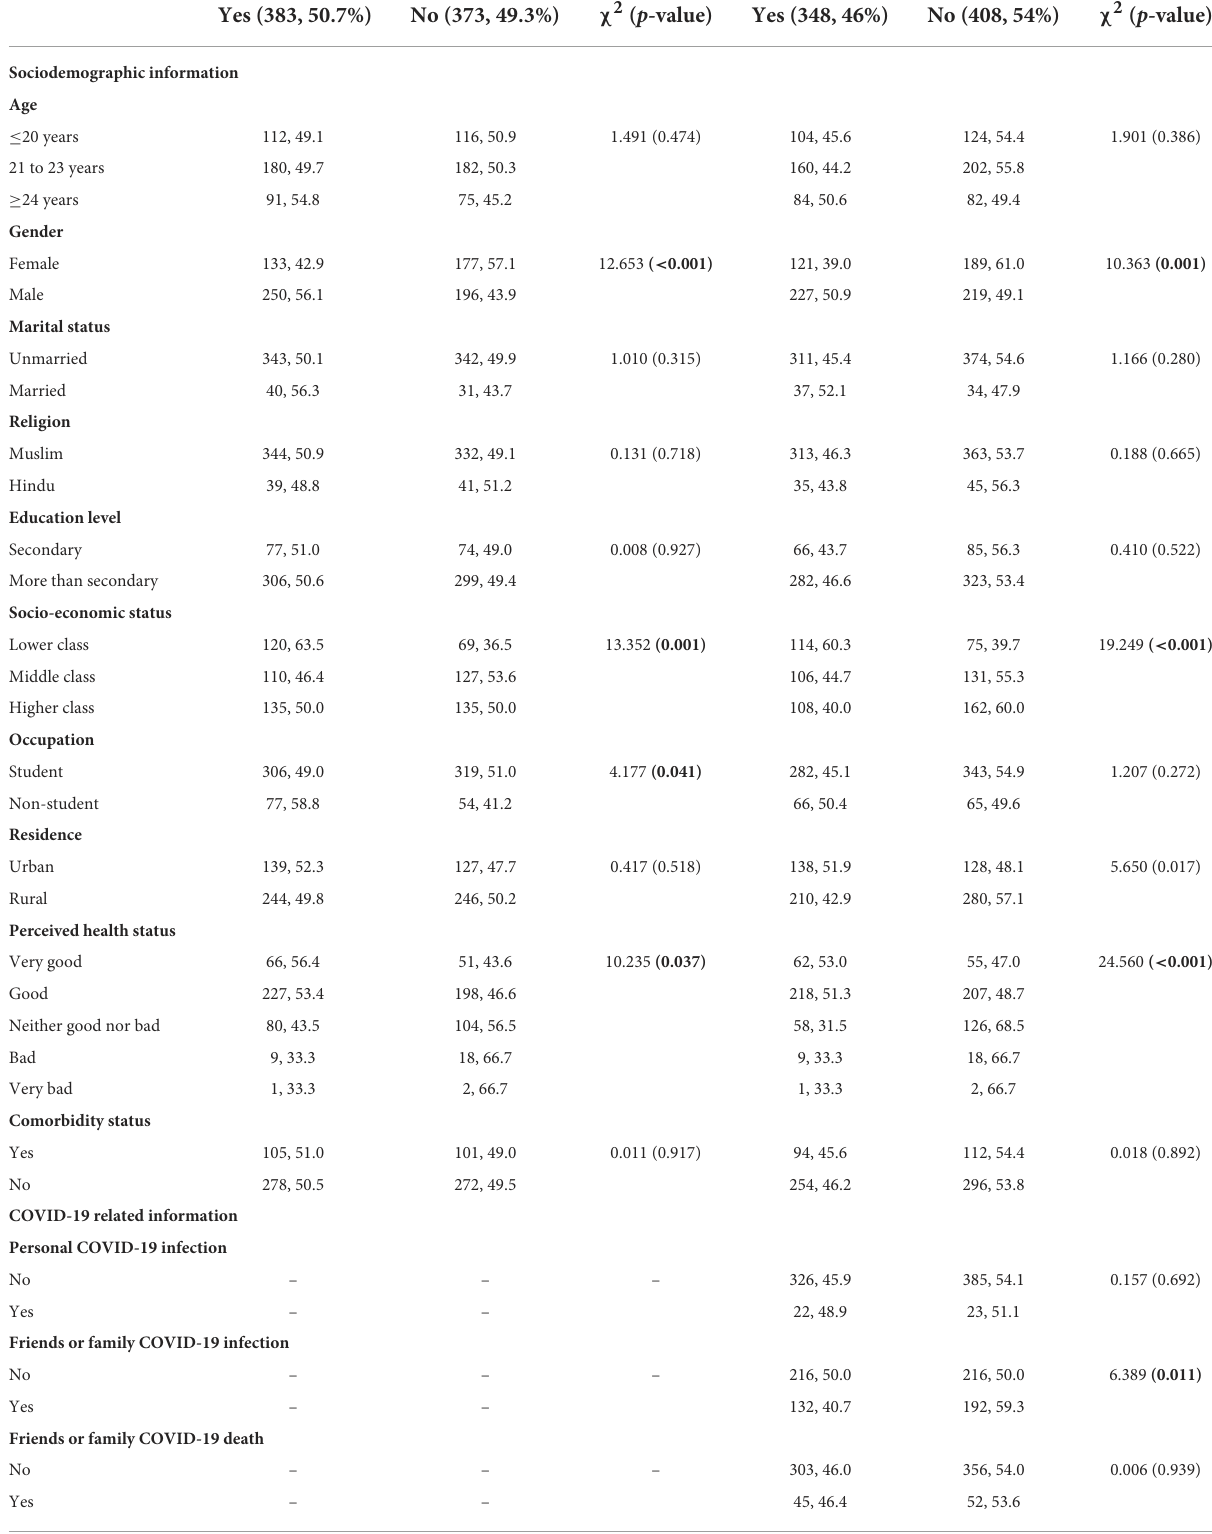
TABLE 4 Association between the independent variables and physical exercise.